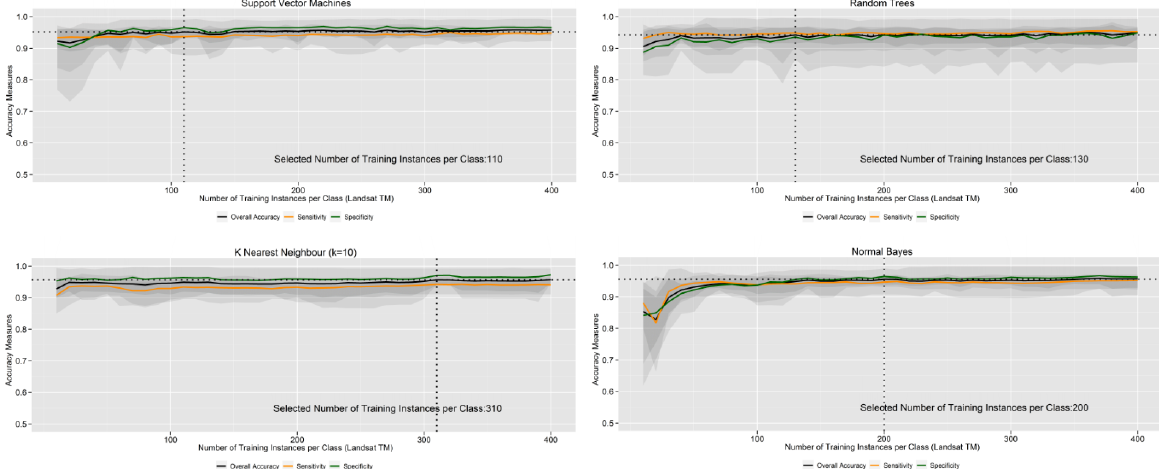
Figure 9. Influence of the training set size on the classification accuracy for TM. Mean and range of accuracy measures from the ten-fold cross-validation are shown for each